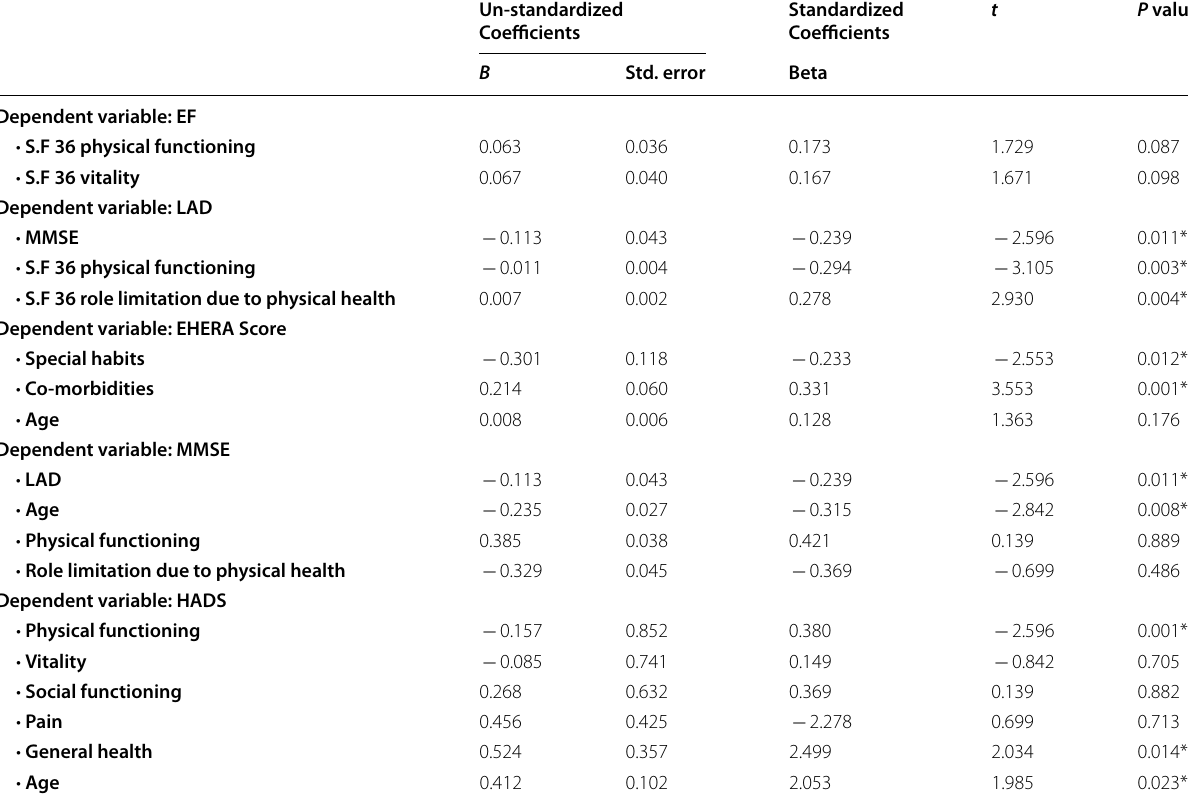
* Significant at p <